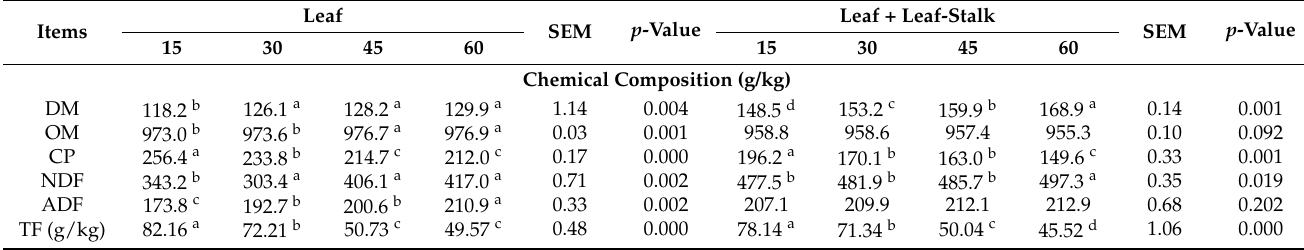
Table 2. Chemical composition in leaf and leaf + leaf-stalk of Brazilian spinach at 15, 30, 45 and 60 days of harvesting.